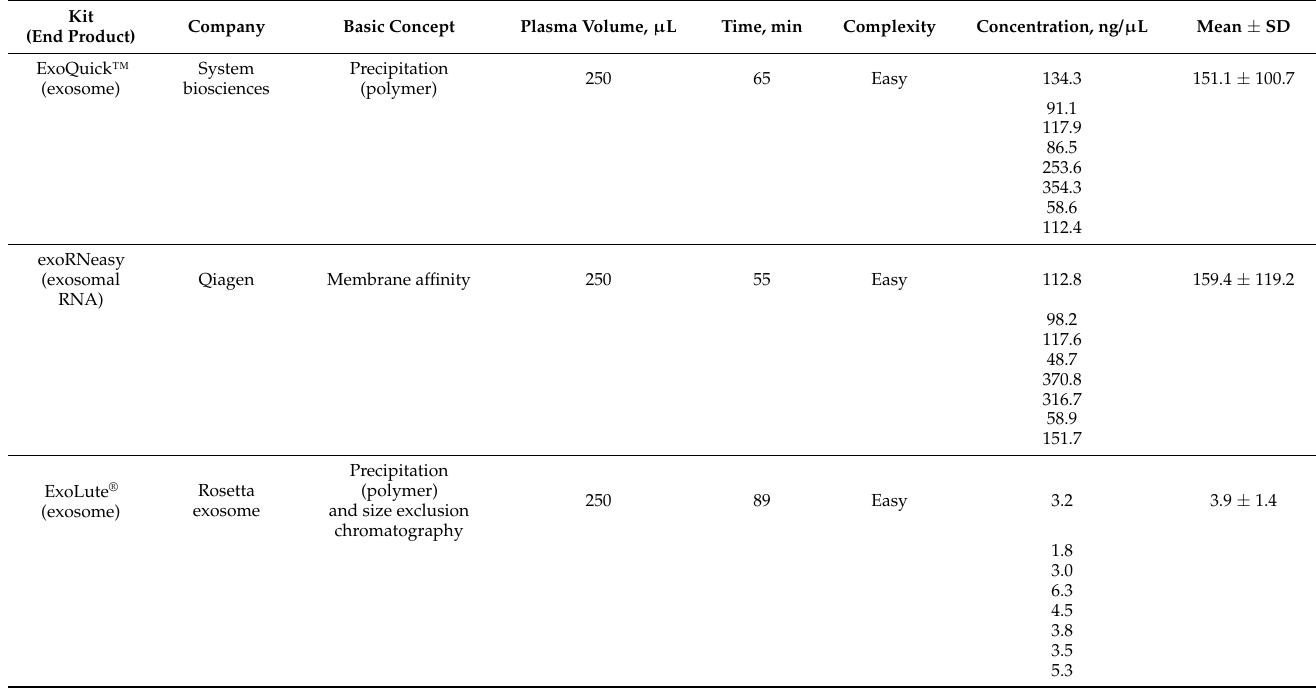
Table 2. Comparison of the exosomal RNA yield according to the exosome extraction kit